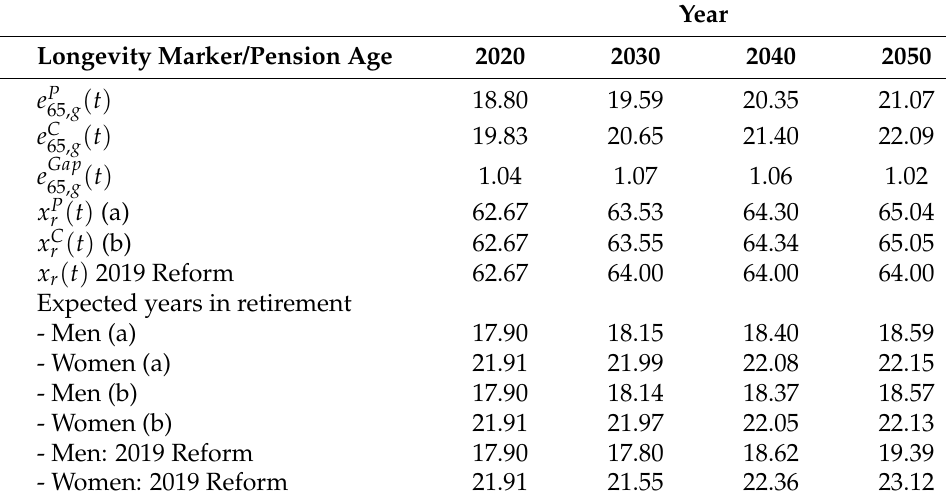
Table 5. SVK: Forecast of life expectancy and pension age